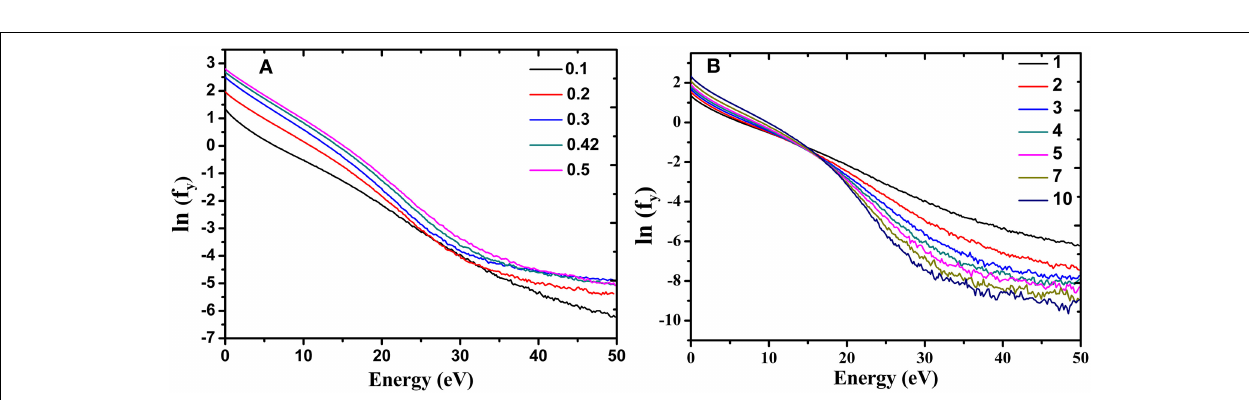
FIGURE 6 | EEPF in y direction at the center for different (A) lengths (in m) and (B) pressure (in